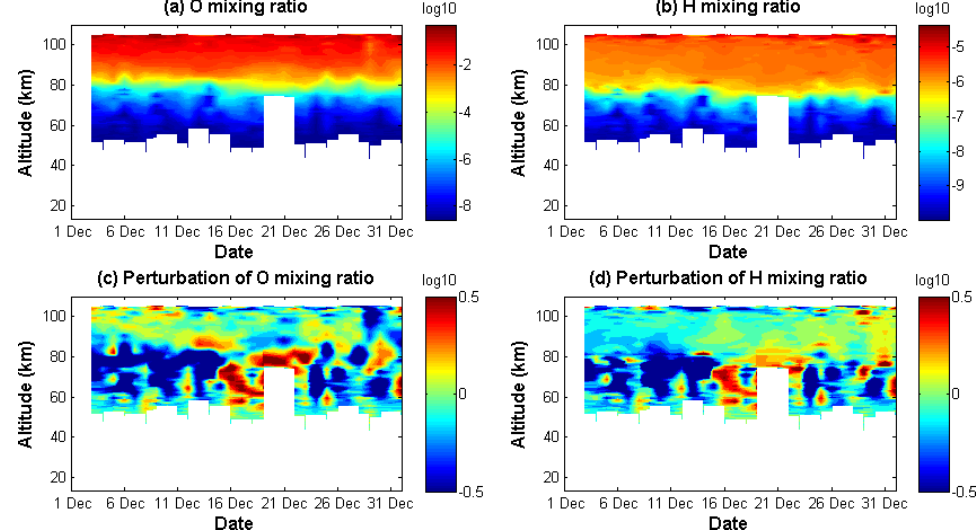
Figure 9. (a, b) The temporal and altitude variations of mixing ratio (in logarithm coordinates) of atomic O and H obtained from SABER/- TIMED. The data within 35–45 ◦ N and 110–120 ◦ E were averaged. (c, d) Their perturbations obtained by subtracting the monthly mean vertical profiles.